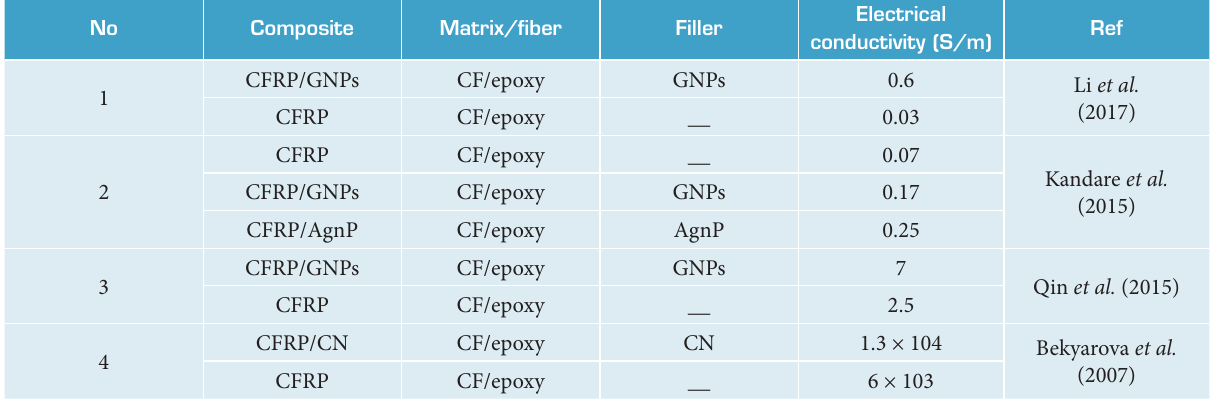
Table 3. The enhancement of electrical conductivity of modified carbon fiber/epoxy composite (CFRPs) using graphene.